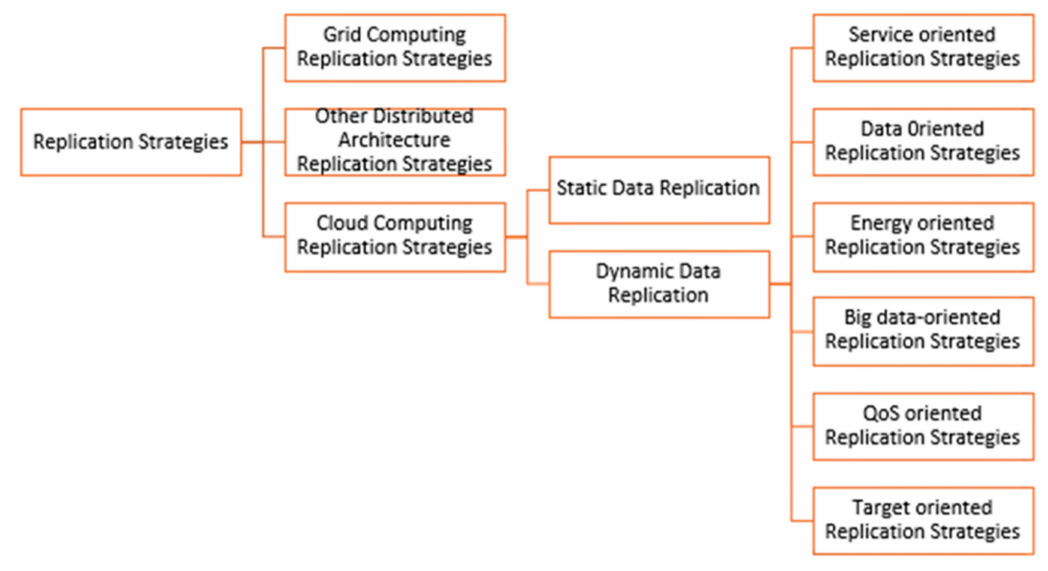
Figure 1. Taxonomy of data replication strategies.